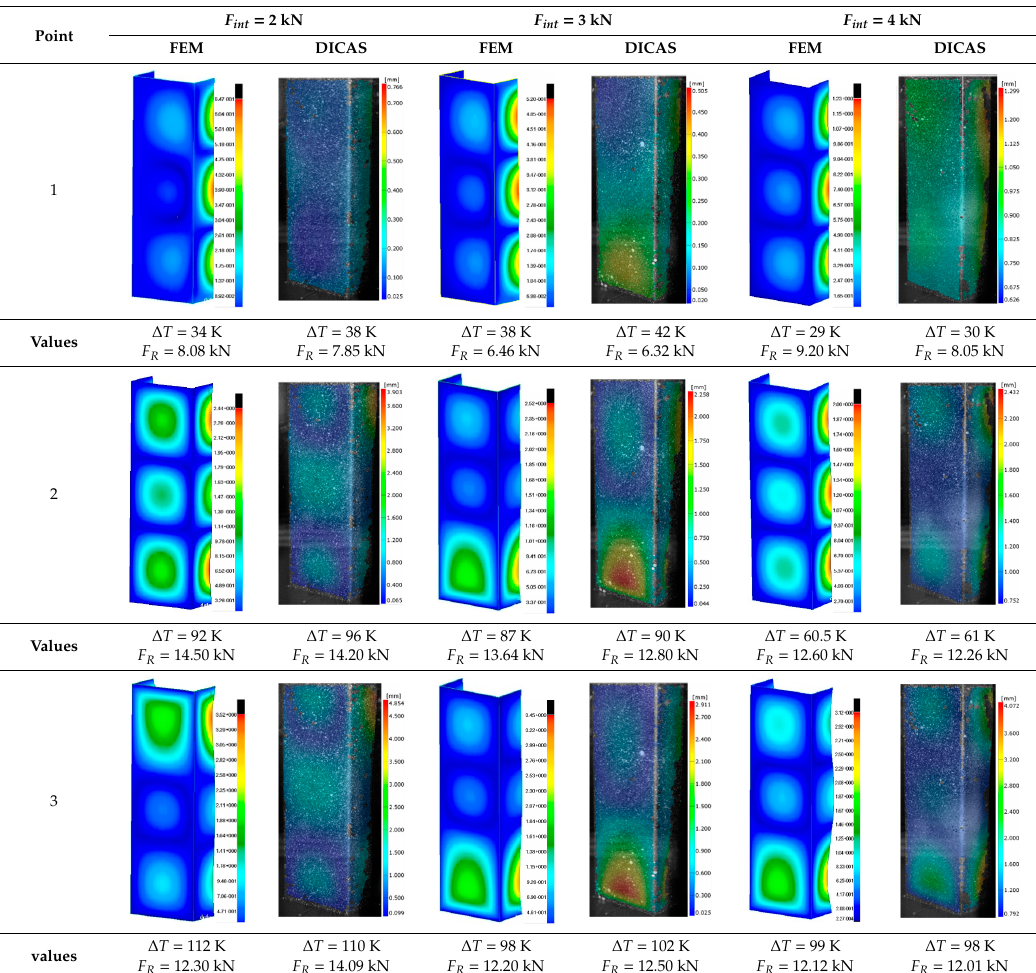
Δ T = 110 Kziwei Δ T = 98 Kziwei Δ T = 102 Kziwei Δ T = 99 Kziwei Δ T = 98 Kziwei F R = 14.09 kN F R = 12.20 kN F R = 12.50 kN F R = 12.12 kN F R = 12.01 kN